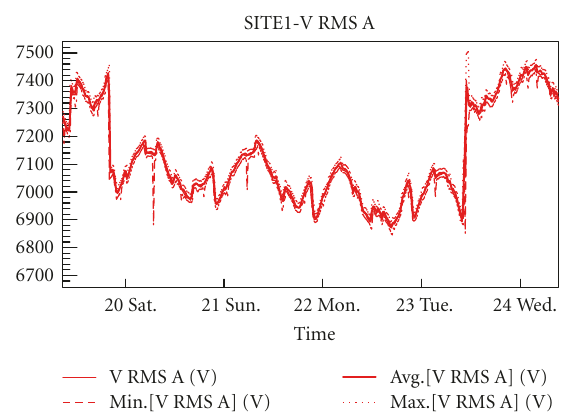
Figure 1: Time trend of an RMS voltage is a standard feature in many PQ analysis software